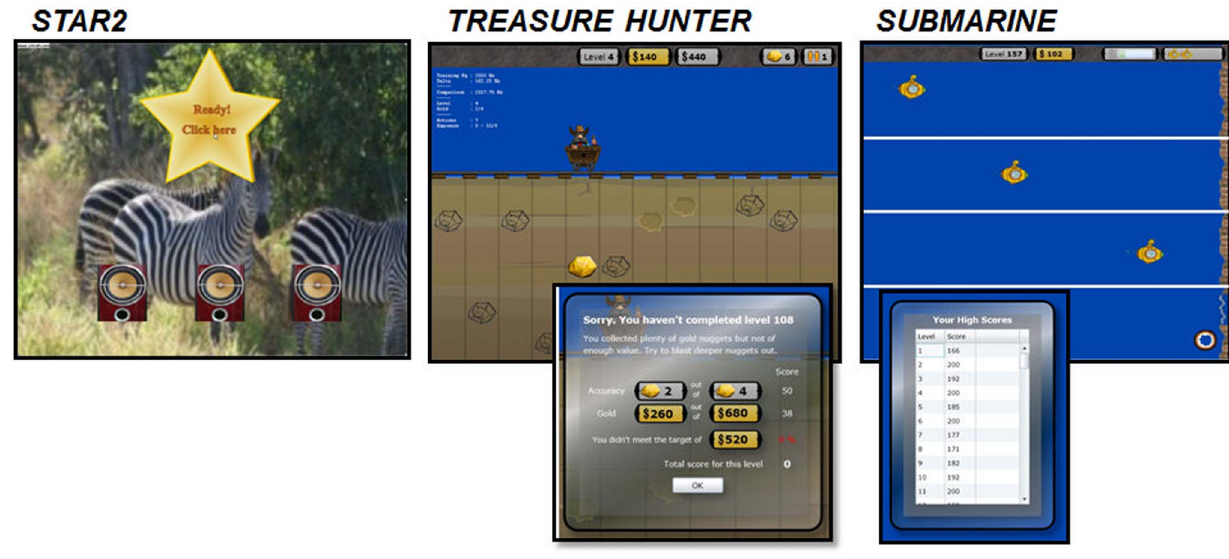
Figure 2. Screenshots of the three training platforms. STAR2 background image rotates through a series of nature scenes unrelated to the task. Treasure Hunter is shown with an example of feedback after a level. Submarine is shown as successive snapshots to reflect movement across the screen, with an example of reward in the form of accrued points for each completed level.